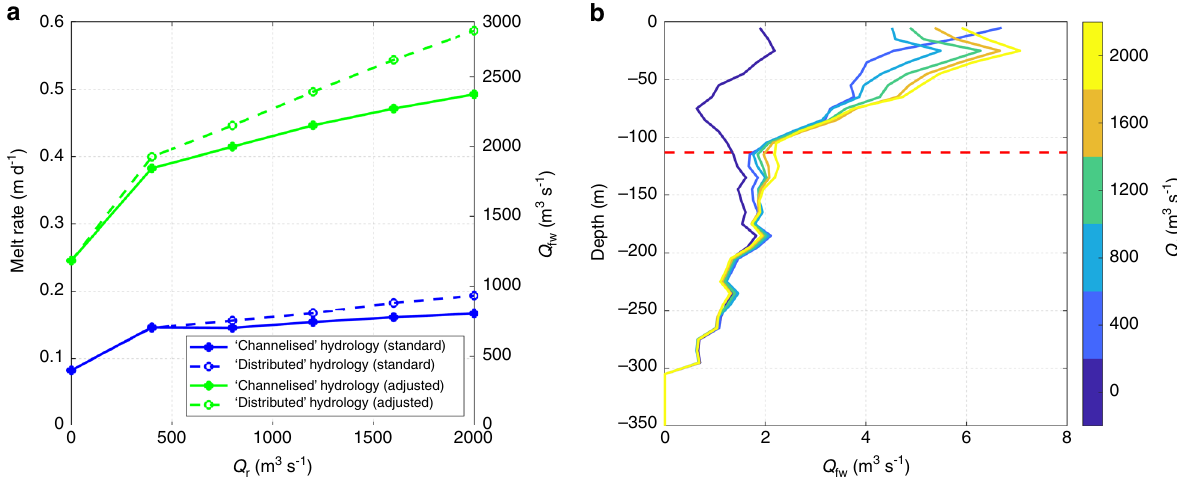
Fig. 2 Iceberg melt rates and freshwater fl ux. a Relationship between runoff ( Q r ) and domain-averaged submarine iceberg melt rate and total iceberg freshwater fl ux ( Q fw ). b Horizontally averaged iceberg freshwater fl ux pro fi le, coloured by runoff, for the ‘ channelised ’ runoff con fi guration and standard melt rate parameter values. The dashed horizontal red line in b donates the 27.3 potential density contour, approximating the depth of the interface between Polar Water and Atlantic Water. In a , the blue lines indicate simulations with standard melt rate parameter values, whilst the green lines indicate simulations with adjusted melt rate parameter values (Methods; Supplementary Table 1). The solid lines represent our ‘ channelised ’ drainage scenario and the dashed lines represent our ‘ distributed ’ drainage